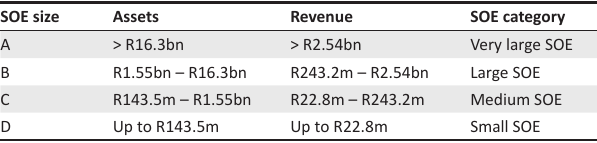
TABLE 1: State-owned enterprise categorisation – assets and revenue. SOE size Assets Revenue SOE category